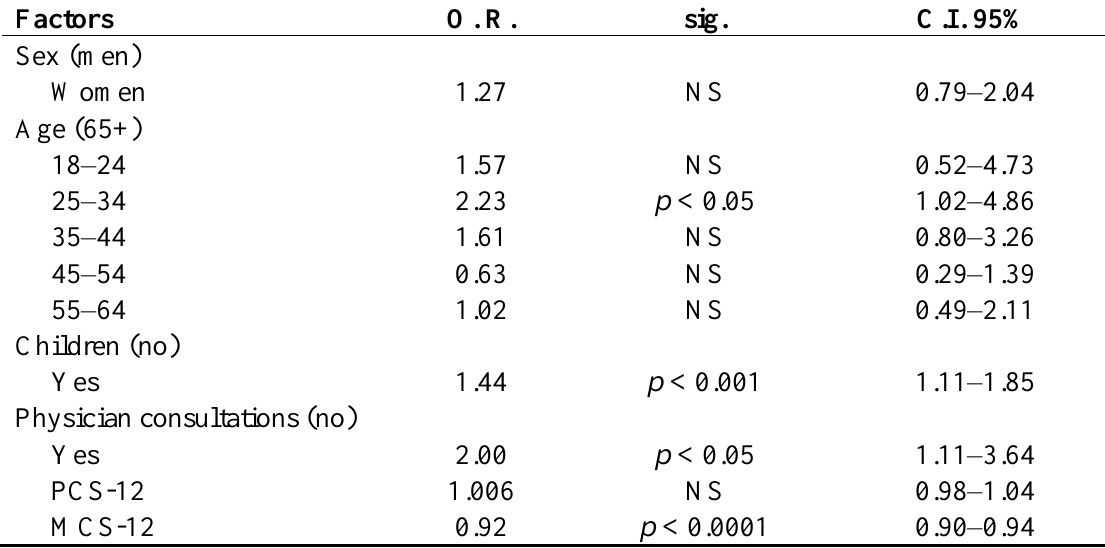
Table 3. Adjusted odds ratio (O.R.) of unmet needs according to various socio-demographic